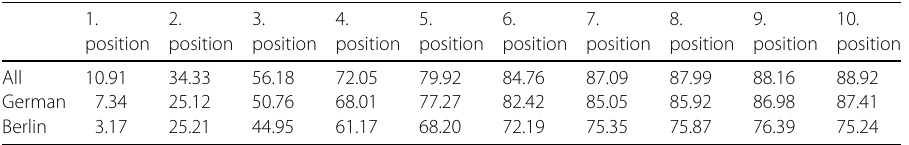
Table 3 Average pairwise deviation (in %) at each rank searching for a party in the respective data set for all result lists, German results and results originated in Berlin